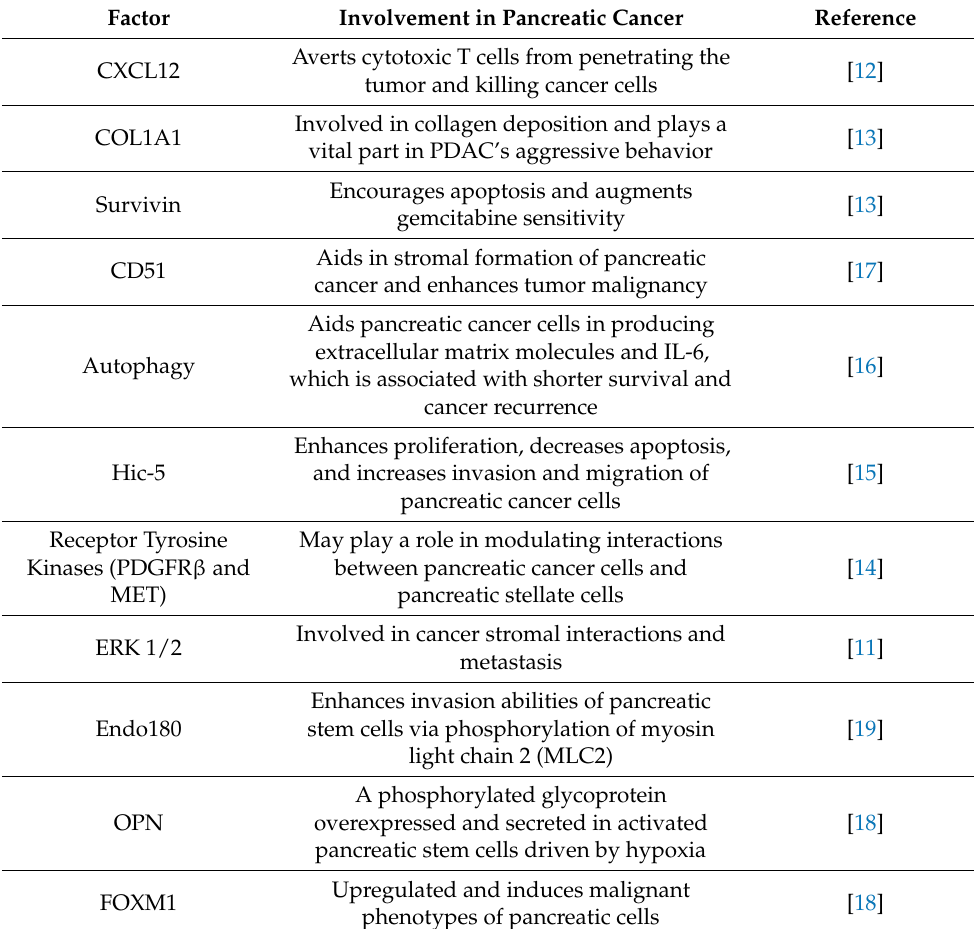
Table 1. Summary of factors that, once inhibited, aid in damaging or severing communication between pancreatic stellate cells and stroma